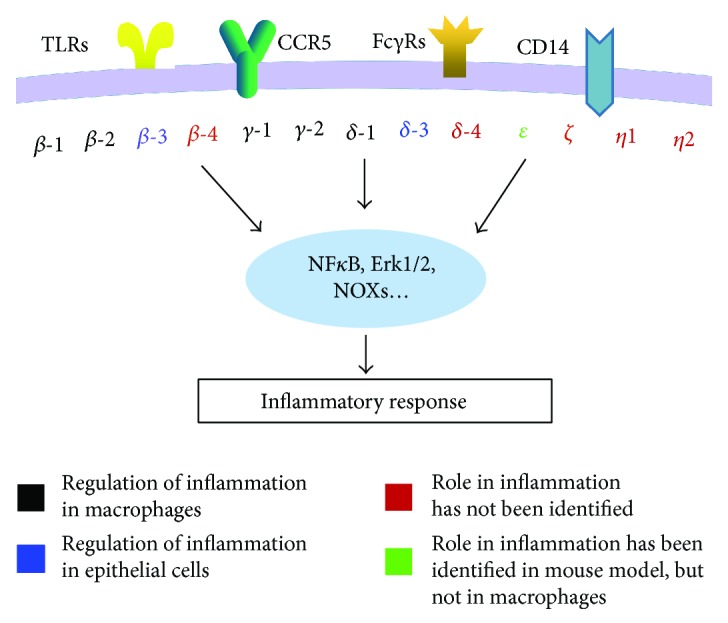
Schematic of macrophage-mediated inflammatory response through PLC signaling. PLCβ1-2, PLCγ1-2, and PLCδ shown in black indicated that these PLC isoforms are expressed in macrophages and are involved in macrophage-mediated inflammatory response. PLCβ3 and PLCδ3 shown in blue indicated that their involvement in inflammatory response has been identified in epithelial cell but not in macrophages. PLCβ4, PLCδ4, PLCζ, and PLCη1-2 shown in red indicated that whether they are involved in inflammatory response has not been identified. PLCε shown in green indicated that the involvement of inflammatory response has been identified with mouse model, in vivo. But whether it regulates inflammatory response in macrophages has not been identified.